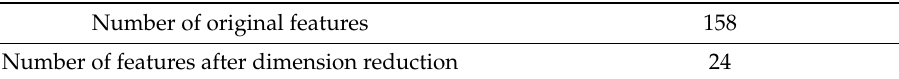
Figure 11. Comparison of global features of fishing boat (blue) and cargo ship (red) trajectories. Table 1. Selected features using